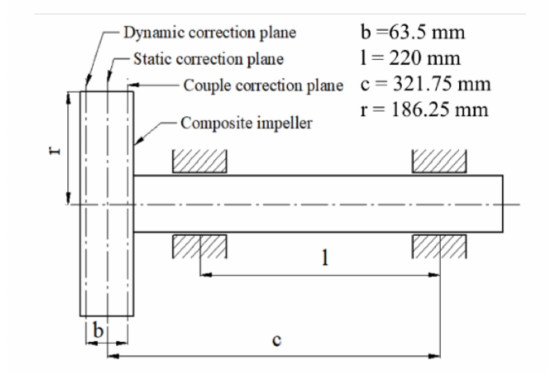
Figure 5. Schematic representation of the balancing